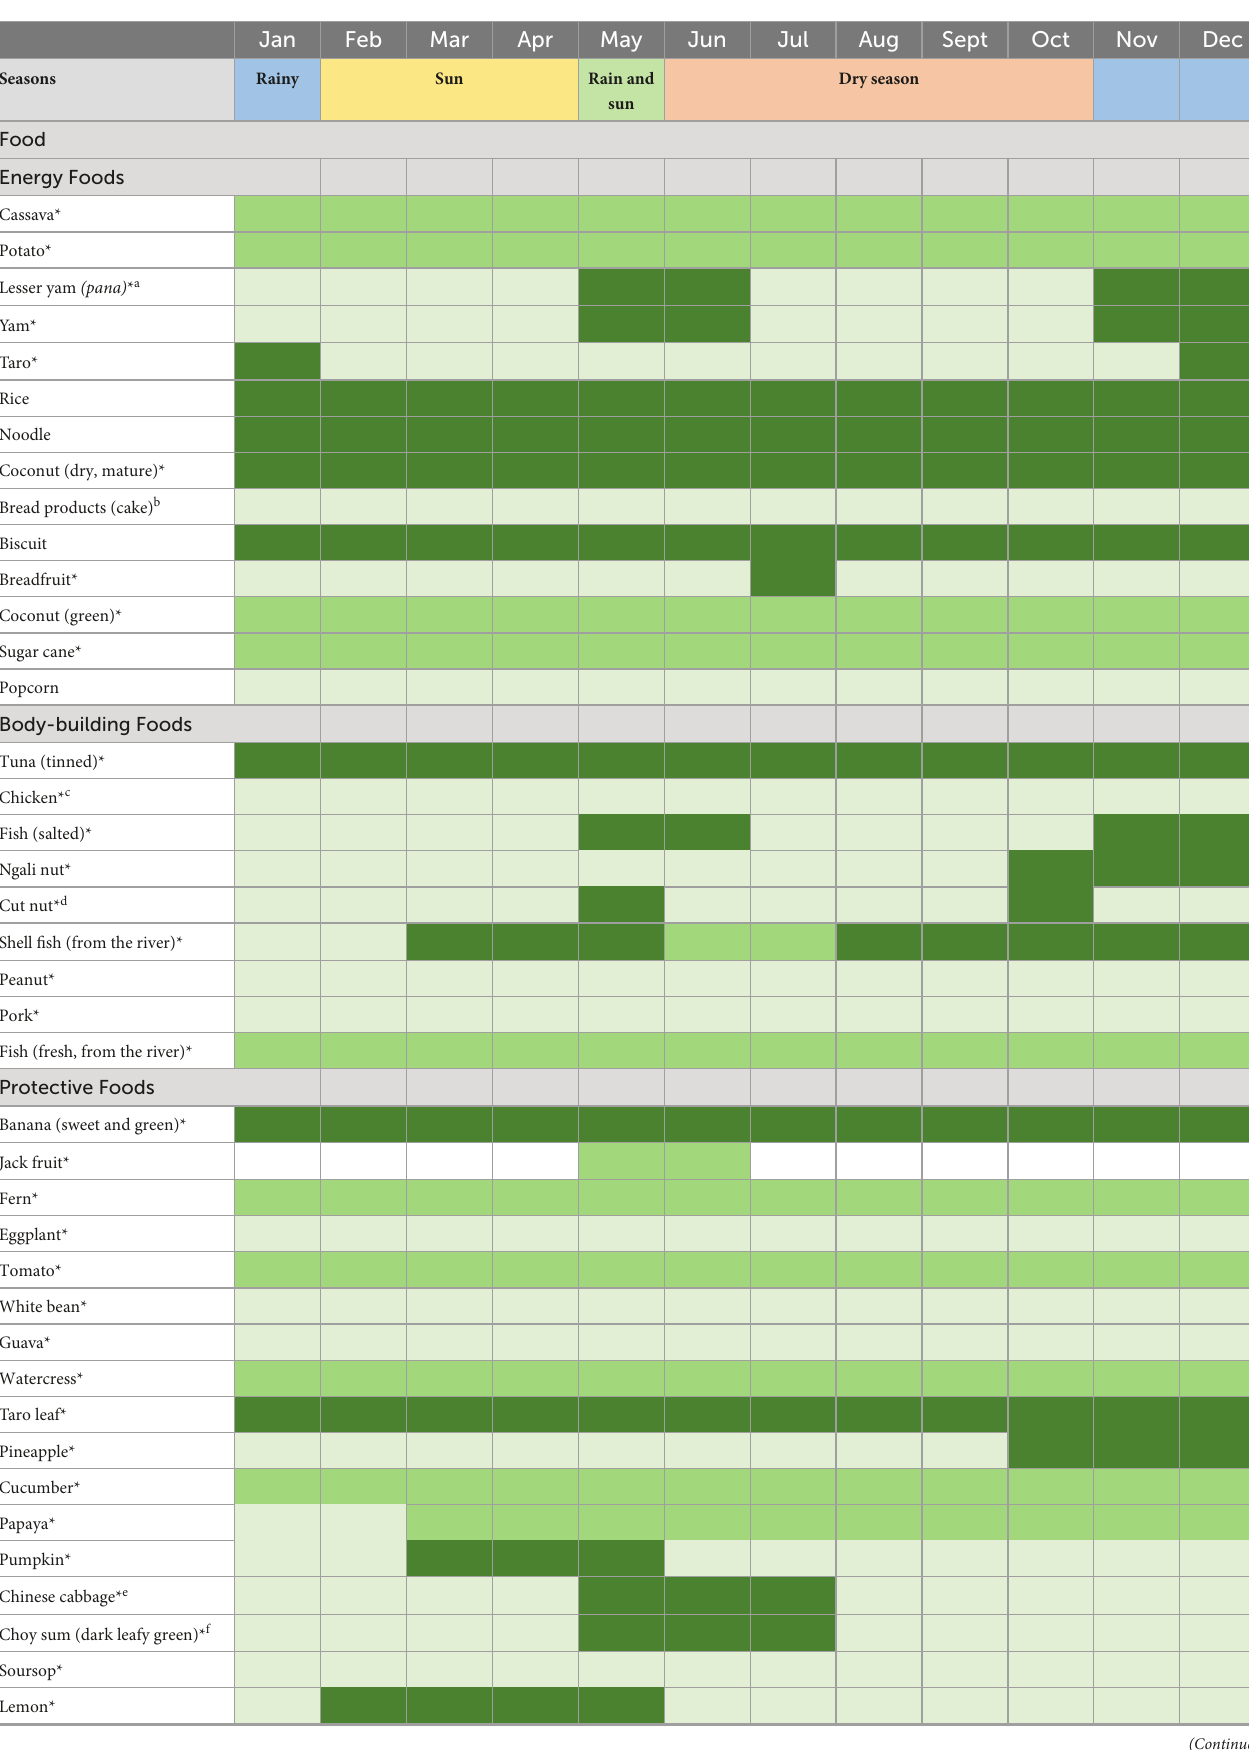
TABLE 5 Seasonal food availability calendar for Malango (rural